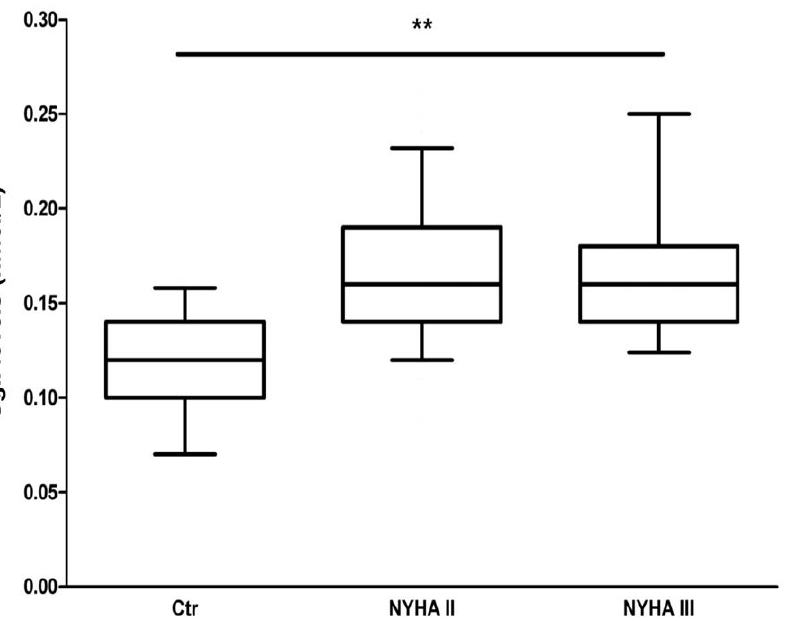
Figure 7. Circulating SgII levels are elevated in patients with chronic, stable HF. SgII levels were significantly increased in HF patients (n=58) compared to healthy age- and gender-matched control subjects (n=20): Median 0.16 (Q1–3 0.14–0.18) vs. 0.12 (0.10–0.14) nmol/L, p , 0.001. HF patients are presented according to NYHA functional class. The horizontal line within the box represents the median level, the boundaries of the box the 25 th and 75 th percentile levels, and the whiskers the 10 th –90 th percentile. **p , 0.001.